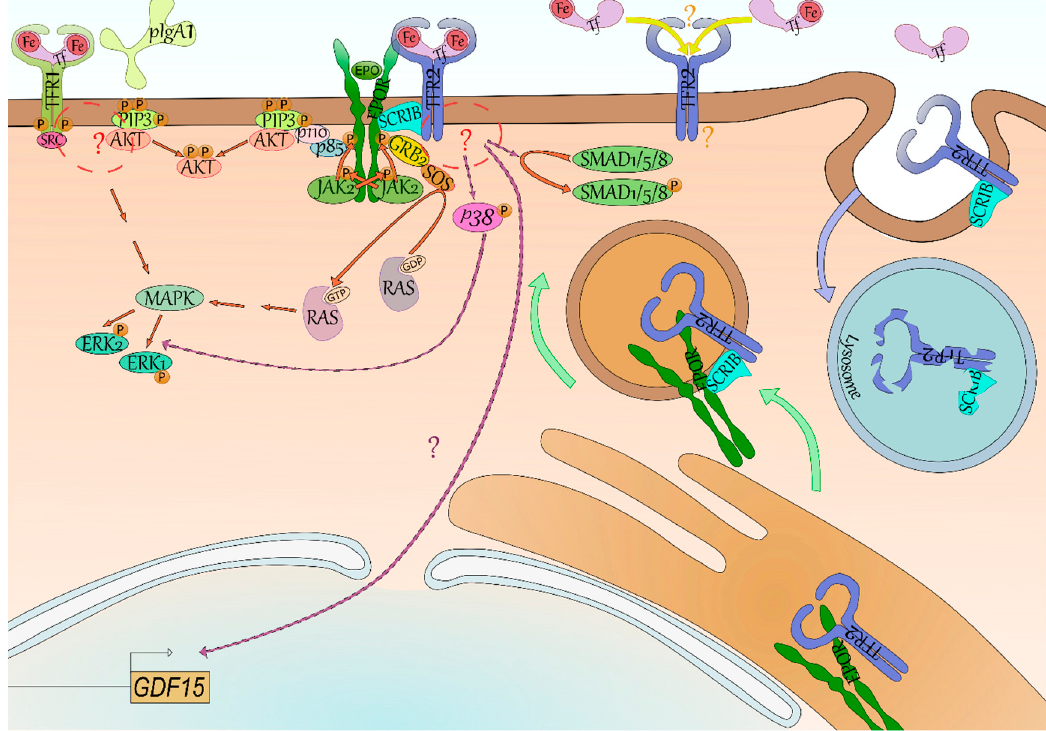
Figure 2. Signaling of the transferrin receptors.